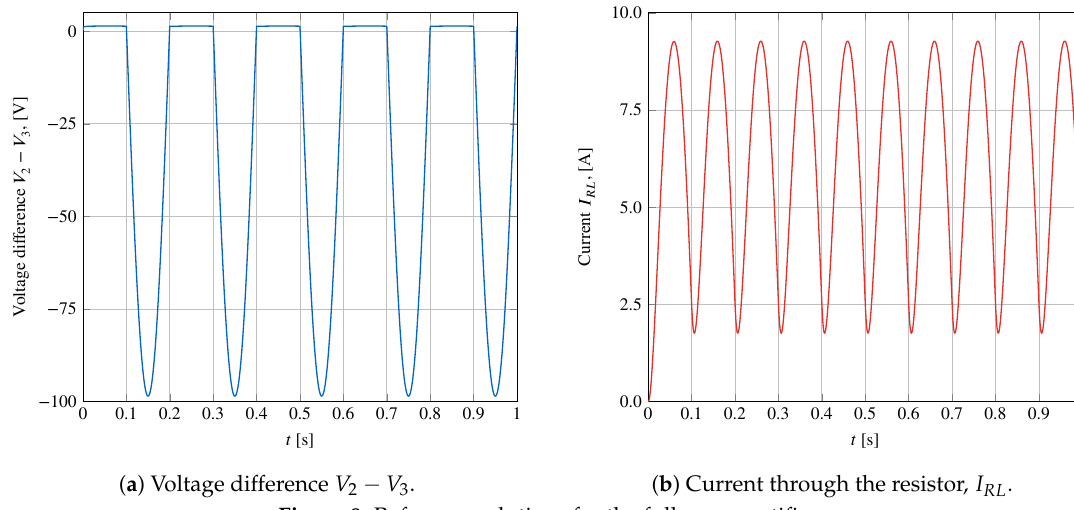
Figure 8. Reference solutions for the full wave rectifier.